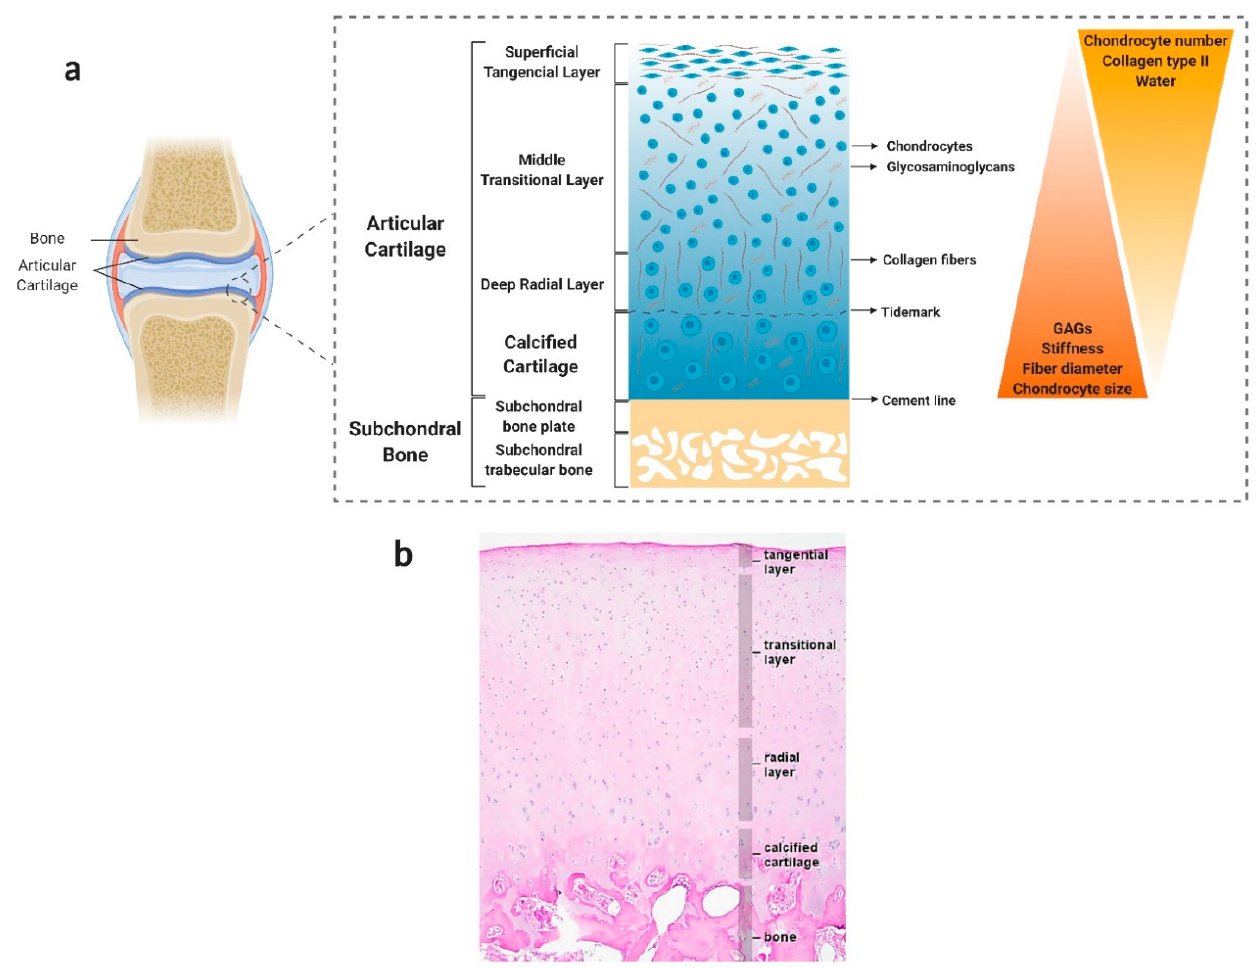
Figure 1. Hierarchical structure, composition, and properties of the native osteochondral (OC) unit. ( a ) Schematic illustration of the OC unit. This multi-tissue region can be divided into three major layers: articular cartilage (AC), which consists of hyaline cartilage tissue; calcified cartilage, which marks the transition from soft cartilage to stiff subchondral bone (SB); and SB, which can be divided into two anatomically distinct layers, the SB plate (cortical-like bone) and the subarticular spongiosa (trabecular-like bone). AC can itself be split into four sublayers based on collagen fibre alignment, proteoglycan composition and chondrocyte number and morphology. From top to bottom, these are the superficial zone, the middle zone, the deep zone, and the calcified zone. Created with BioRender.com (accessed on 30 March 2021). ( b ) Representative histological image of the OC unit. Adapted from [84] with permission from Elsevier. Copyright © 2009, Elsevier Ltd.